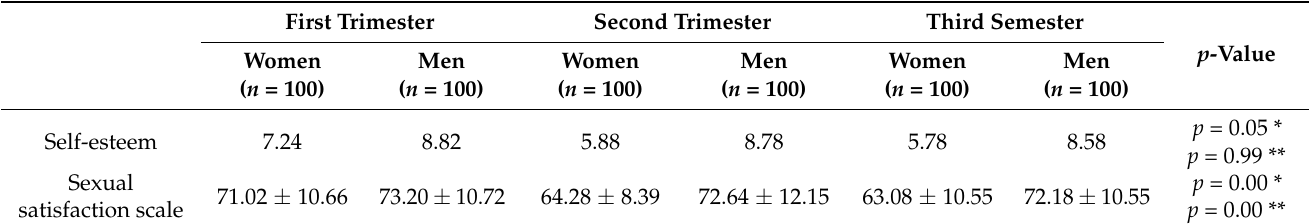
Table 5. The sexual satisfaction self-assessment (SARSS) and sexual satisfaction scale (DSSS) during the course of